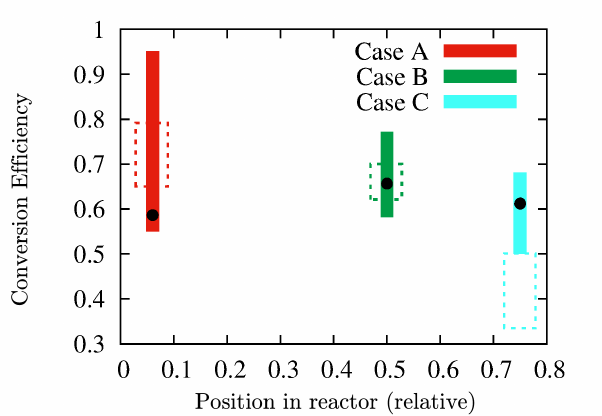
Figure 7. Comparison between the conversion parameters obtained from the LBM simulations and the theoretical and experimental results from [51].The black dots represent LBM results; the dashed rectangular boxes describe the uncertainty around the experimental values; the vertical colored stripes represent the reference theoretical